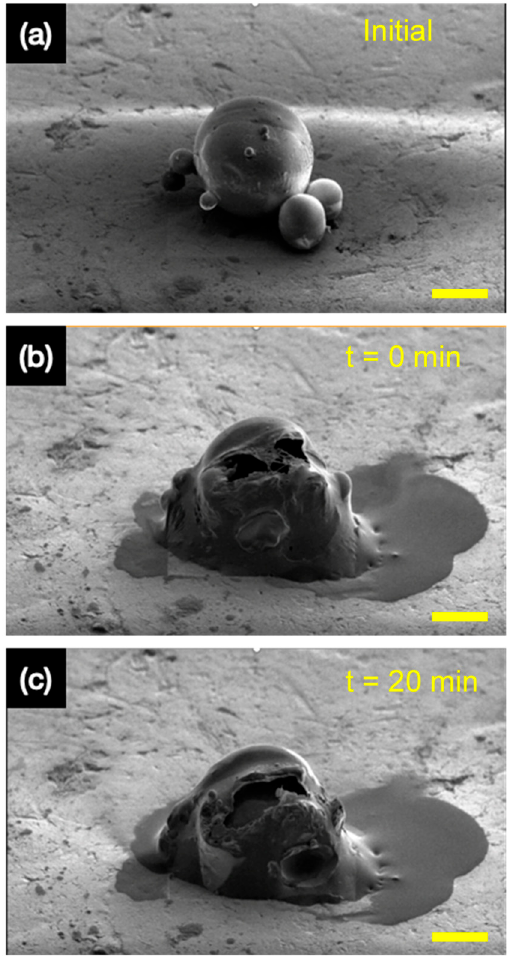
Figure 10. The release of tung oil during the cutting process of the microcapsule with the use of FIB ( a ) microcapsule before the rupture, ( b ) microcapsule after the initial rupture, ( c ) microcapsule 20 min after the initial rupture. All scale bars are 20 µm.